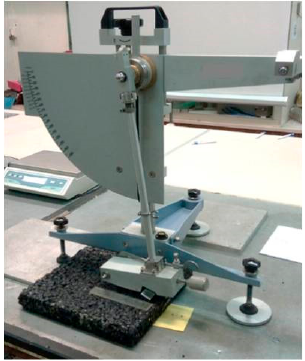
Figure 7. The utilized BPT device.